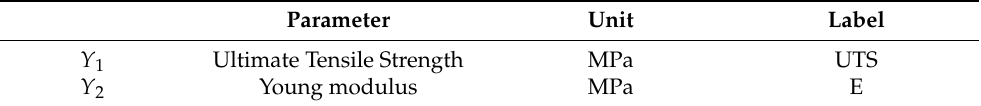
Table 2. Outputs ( Y s )—selected product properties of the electrospun PSU membrane. Parameter Unit